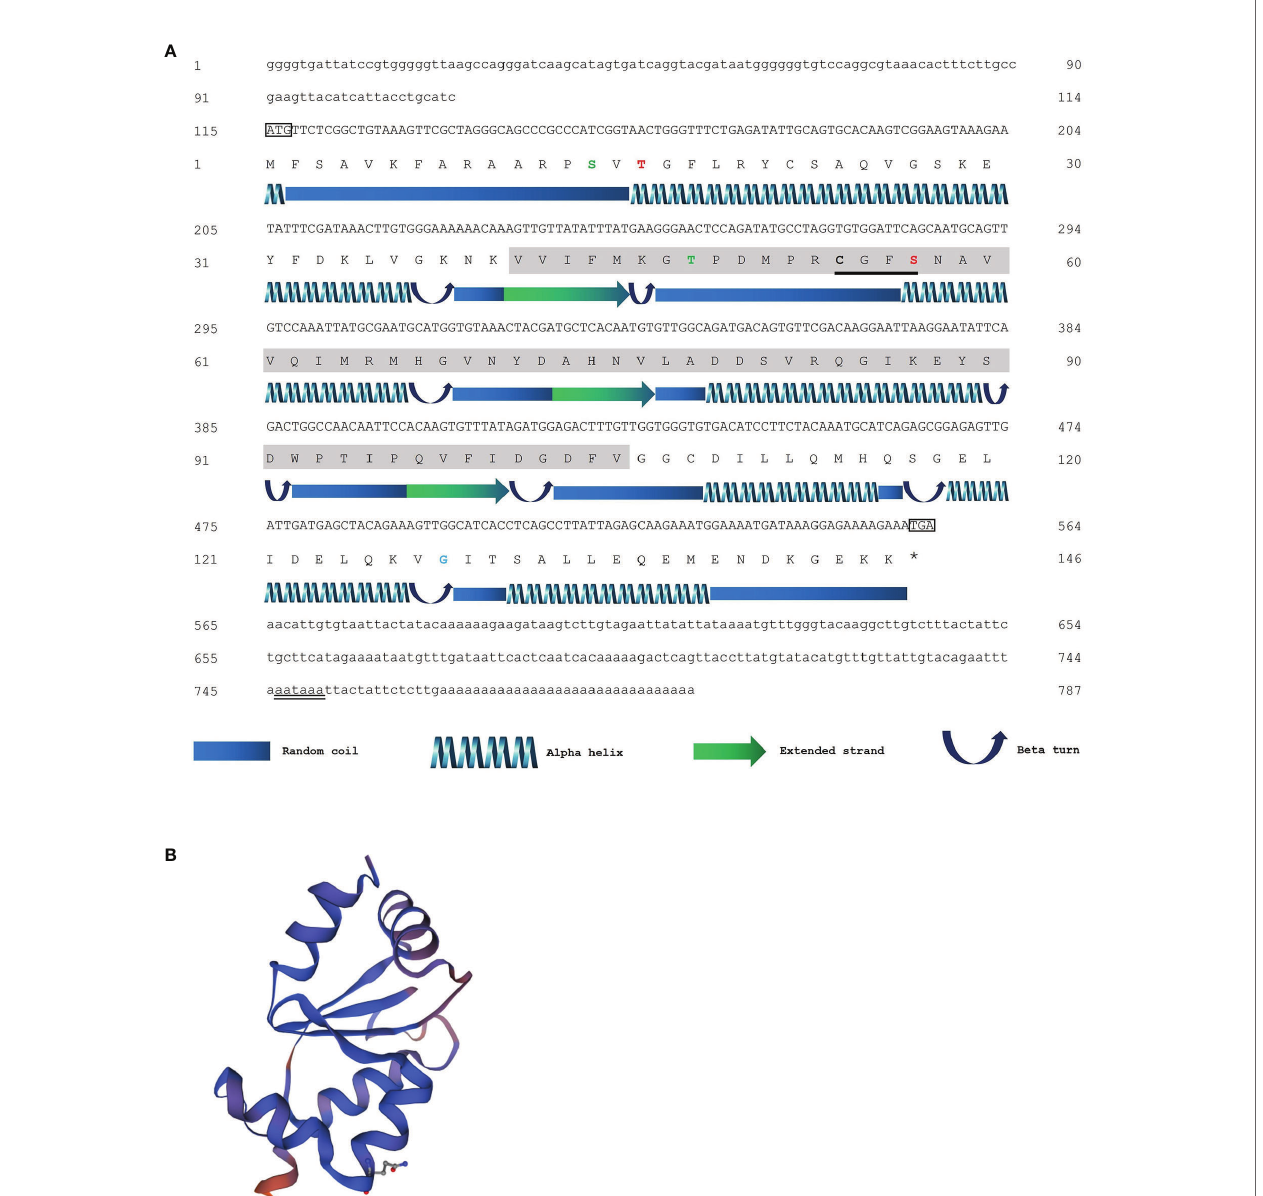
FIGURE 1 | (A) The sequence of nucleotides, the deduced sequence of amino acids, and the putative secondary structure of PmGrx5 . The initiation codon “ ATG ” and the termination codon “ TAA ” are marked in the rectangular box. The polyadenylation signal sequence (AATAAA) is marked using a double underline. The gray region indicates the predicted glutaredoxin (Grx) structural domain. The active center sequence (C-G-F-S) of the Grx domains is marked using a single underline. Cys residues are marked in bold. The phosphorylation sites, glycosylation sites, and N-myristoylation sites are highlighted in green, red, and blue, respectively. The legend of the predicted secondary structure is annotated at the bottom of the image. (B) The putative tertiary structure of PmGrx5